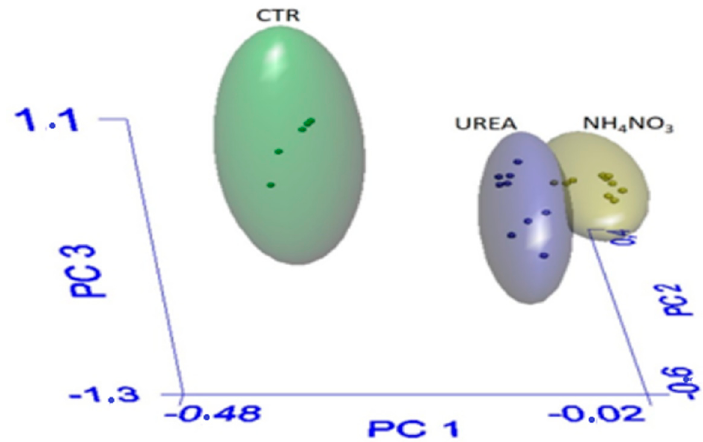
Figure 3. Three-dimensional principal component analysis (PCA) scores plot according with SIMCA algorithm of seeds from hemp plants fertilized by ammonium nitrate (NH 4 NO 3 ) and urea. CTR, control seeds. PC1, PC2, and PC3 are three independent variables. Table 3. Inter Material Distances.